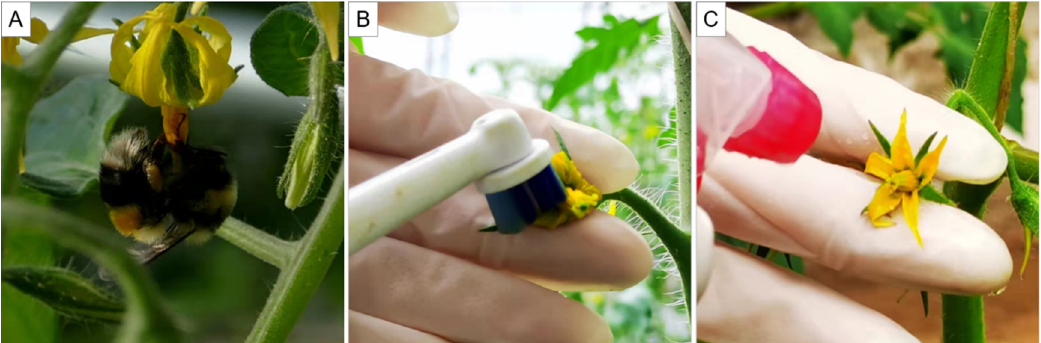
Figure 1. Pollination treatments on greenhouse tomato. ( A ) Bumblebee Bombus lantschouensis pollination; ( B ) vibrator treatment; and ( C ) plant growth regulator treatment.